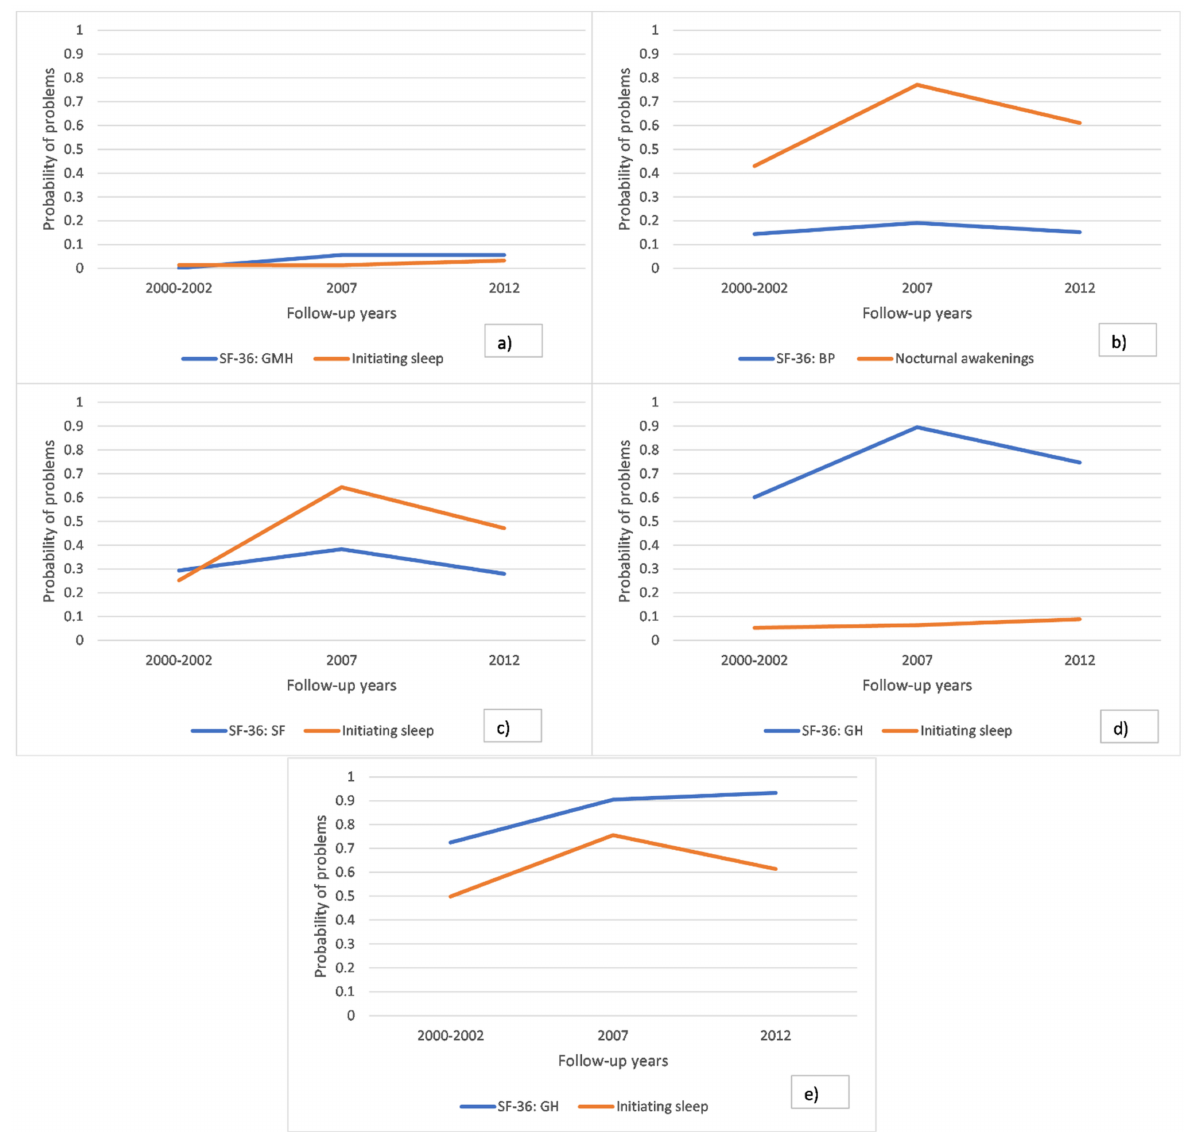
Figure 1. ( a ) An example of LC1 (reference class: stable good sleep and good functioning), from the RMLCA model with General Mental Health and Difficulties of initiating sleep as indicators of the latent classes. ( b ) An example of LC2 (persistent sleep problems), from the RMLCA with Bodily Pain and Nocturnal awakenings as indicators of the latent classes. ( c ) Another example of LC2 (persistent sleep problems), from the RMLCA with Social Functioning and Difficulties of initiating sleep as indicators of the latent classes. ( d ) An example of LC3 (Poor health functioning), from the RMLCA with General Health perception and Difficulties of initiating sleep as indicators of the latent classes. ( e ) An example of LC4 (Problematic sleep and health functioning), from the RMLCA with General Health perception and Difficulties of initiating sleep as indicators of the latent